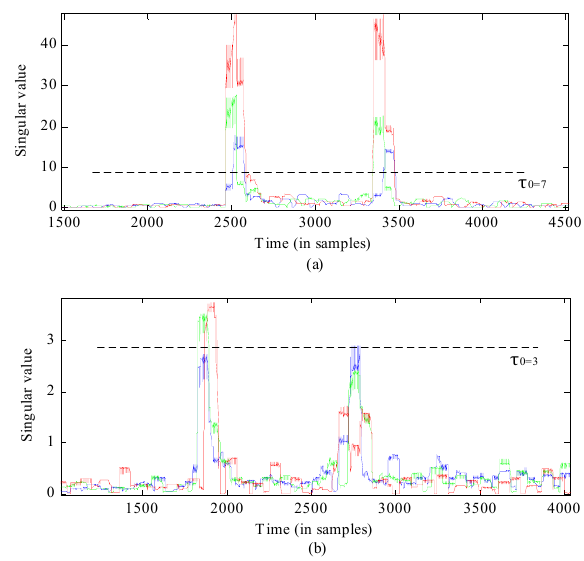
Figure 6. The singular values of two field measurements. ( a ) event with obvious voltage drop; ( b ) event with slight voltage drop.